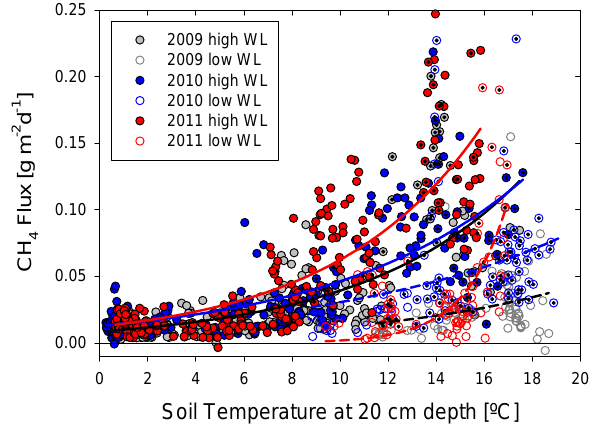
Fig. 6. Upper panel: deviation of measured daily CH 4 fluxes from a simple model based on exponential temperature functions for two different water level (WL) classes. The functions were fitted to the entire 3yr data series excluding the periods with grazing (Ta- = 0 . 0106 · e 0 . 149 T ble 3). For high WL the function was F CH 4 , hw = 0 . 0049 · e 0 . 112 T ( R 2 = 0 . 54) and for low WL it was F CH 4 , lw ( R 2 = 0 . 10) where T is the soil temperature [ ◦ C] at 20cm depth. Lower panel: time course of volumetric soil water content at 20cm depth in a slightly elevated location near the instrument mast. The broken line indicates the estimated field capacity (FC) of the soil and the arrows indicate the time in late summer when FC was reached for the first time in the respective growing